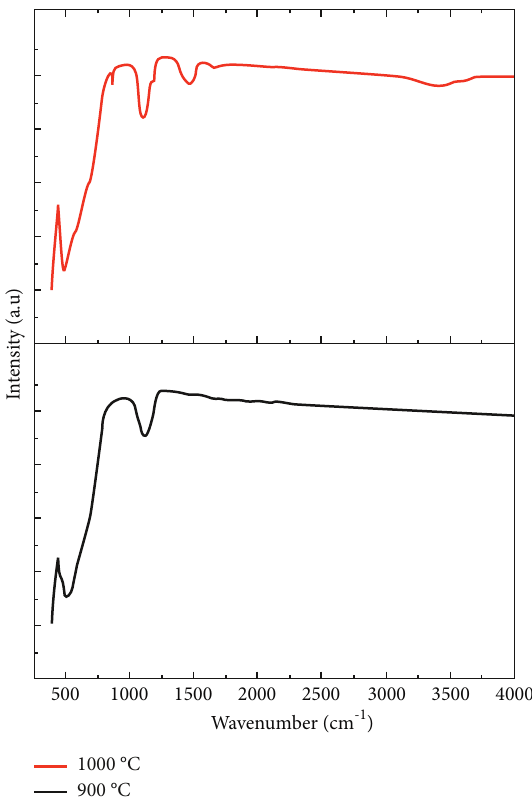
Figure 10: FTIR spectra of CaTiO 900 ° C and 1000 °